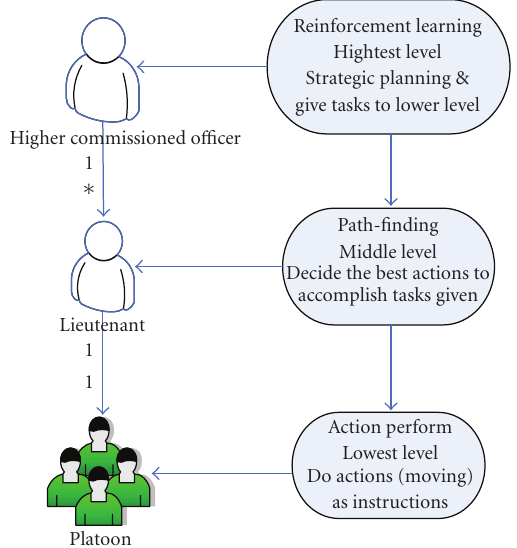
Figure 2: AI-based learning